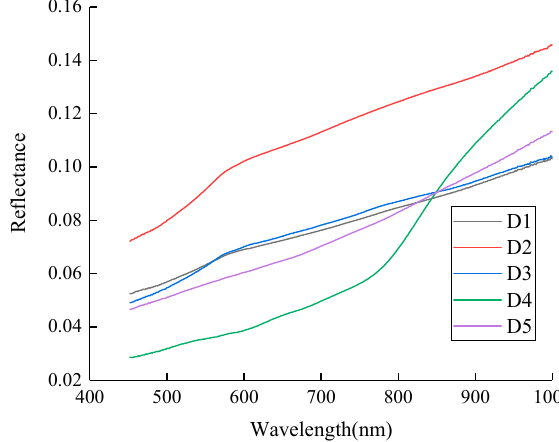
Figure 9. Spectral reflectance of dust samples.